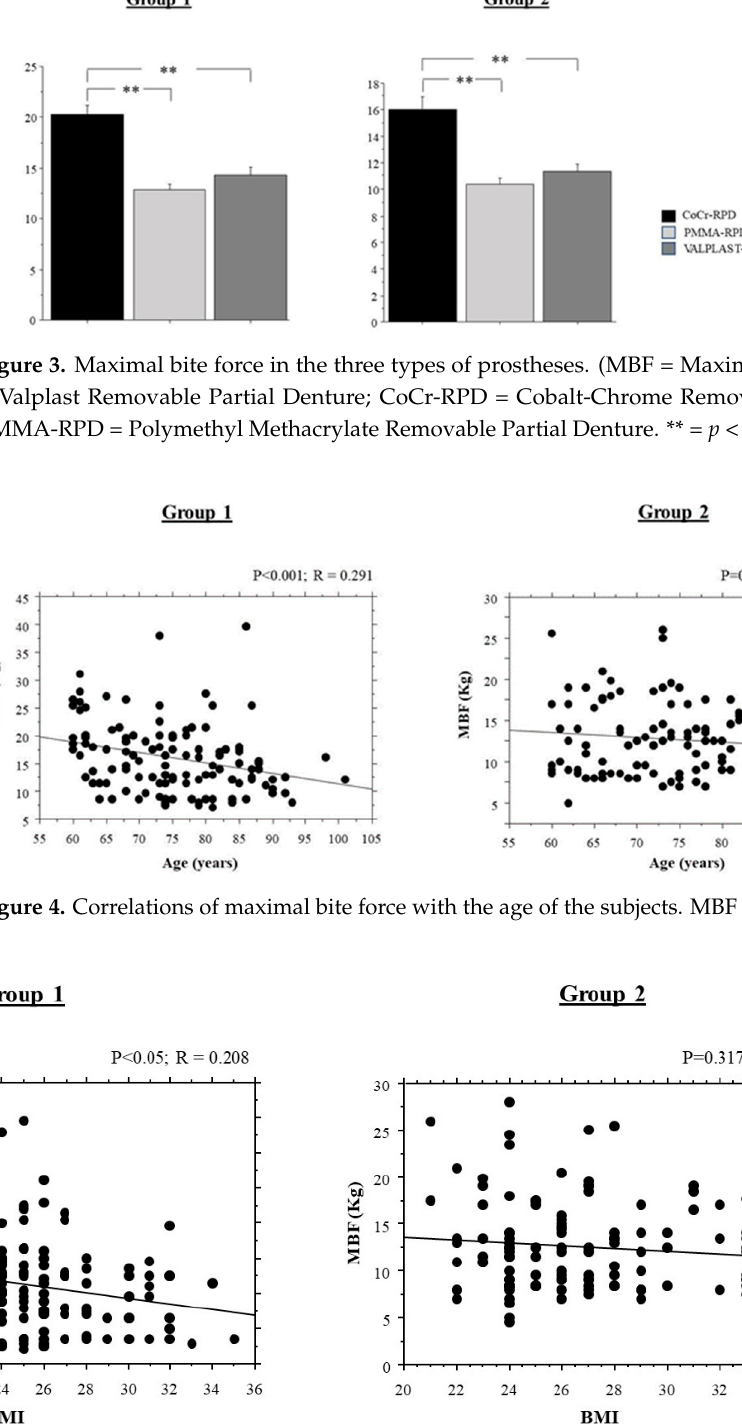
Figure 5. Correlations of maximal bite force with body mass index. MBF = Maximal Bite Force.